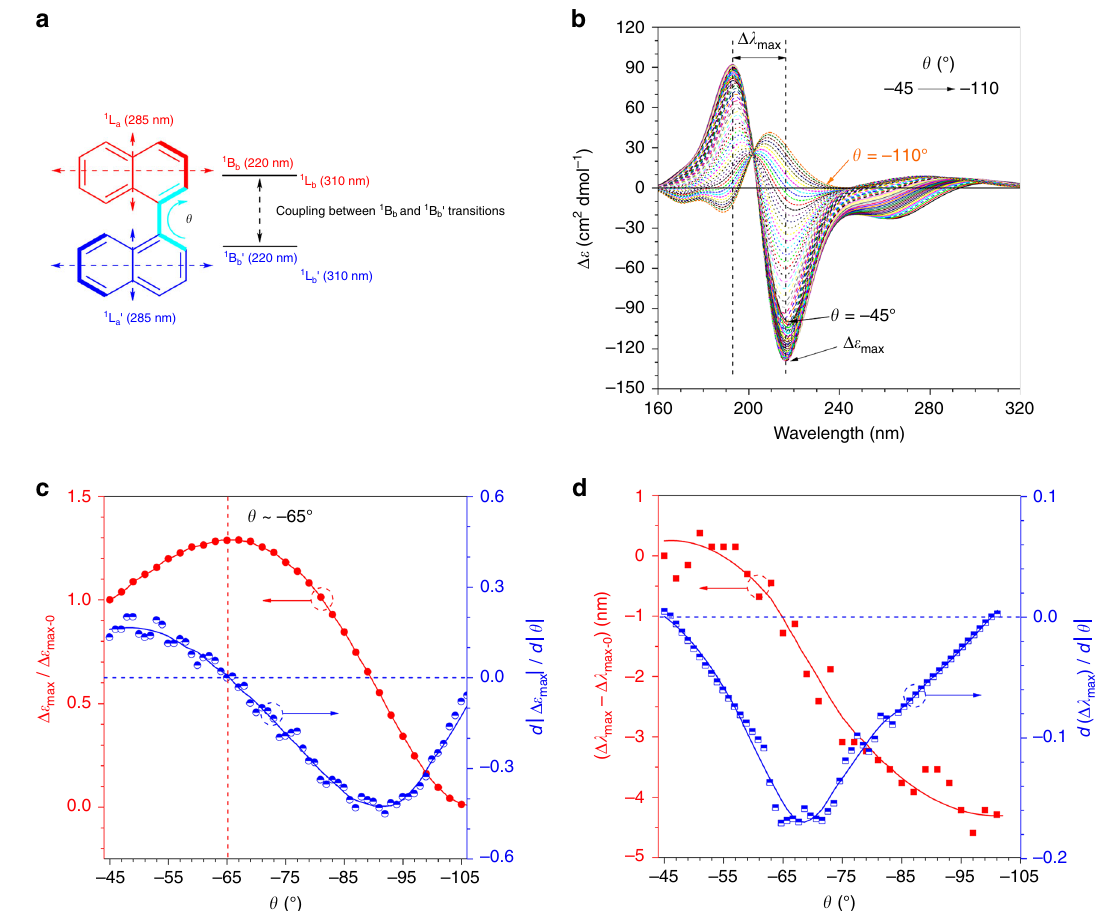
Fig. 1 Simulated chiroptical properties of binaphthyl. a Schematic of polarization directions of the main electronic transition moments and the torsion angle θ of ( R ) − 1,1 ′ -binaphthyl derivatives. b Simulated circular dichroism spectra of ( R )-1,1 ′ -binaphthol with θ varying from − 45 to − 110° in 1° intervals. c Plot of Δε Δε θ (red line) and the fi rst-order derivative of d | Δε d | θ | (blue line), Δε = negative circular dichroism couplet intensity at ~220 max / max-0 versus max |/ max nm and Δε max-0 = Δε max at θ = − 45°. d Plots of Δ λ max − Δ λ max-0 versus θ (red line) and the fi rst-order derivative of d | Δ λ max |/ d | θ | (blue line). The red dots in Fig. 1c,d were smoothed using the Savitzky – Golay method. Δ λ max = Davydov splitting width shown in Fig. 1b according to the Mason model 23 , Δ λ max-0 = Δ λ θ = − 45°. Calculated with CAM-B3LYP/6-31 G*, Nstates = 30, Gaussian 09 Program max at